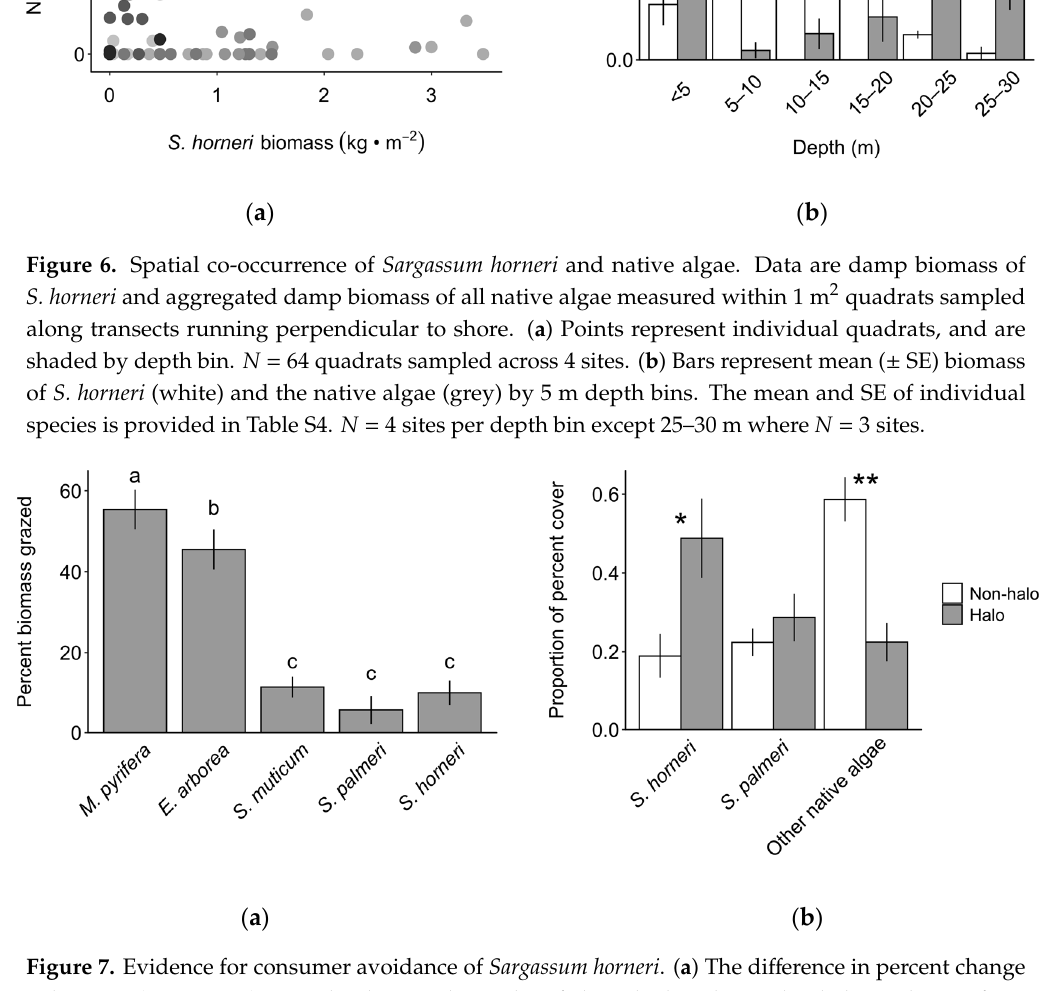
Figure 6. Spatial co-occurrence of Sargassum horneri and native algae. Data are damp biomass of S. horneri and aggregated damp biomass of all native algae measured within 1 m 2 quadrats sampled along transects running perpendicular to shore. ( a ) Points represent individual quadrats, and are shaded by depth bin. N = 64 quadrats sampled across 4 sites. ( b ) Bars represent mean (± SE) biomass of S. horneri (white) and the native algae (grey) by 5 m depth bins. The mean and SE of individual species is provided in Table S4. N = 4 sites per depth bin except 25–30 m where N = 3 sites.